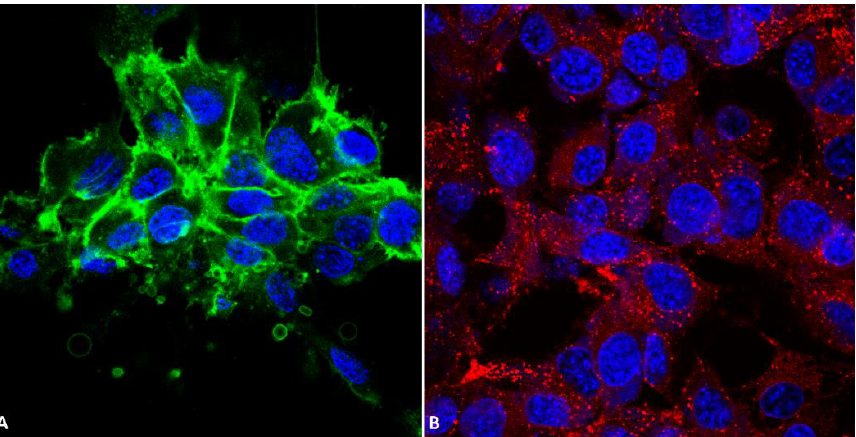
Figure 6. Confocal images of labeled cmSA-C17.2. ( A ) : cmSA-C17.2 labeled with biotin (5-fluorescein). ( B ) : cmSA-C17.2 labeled with PLGA-rhodamine-biotin nanoparticles.